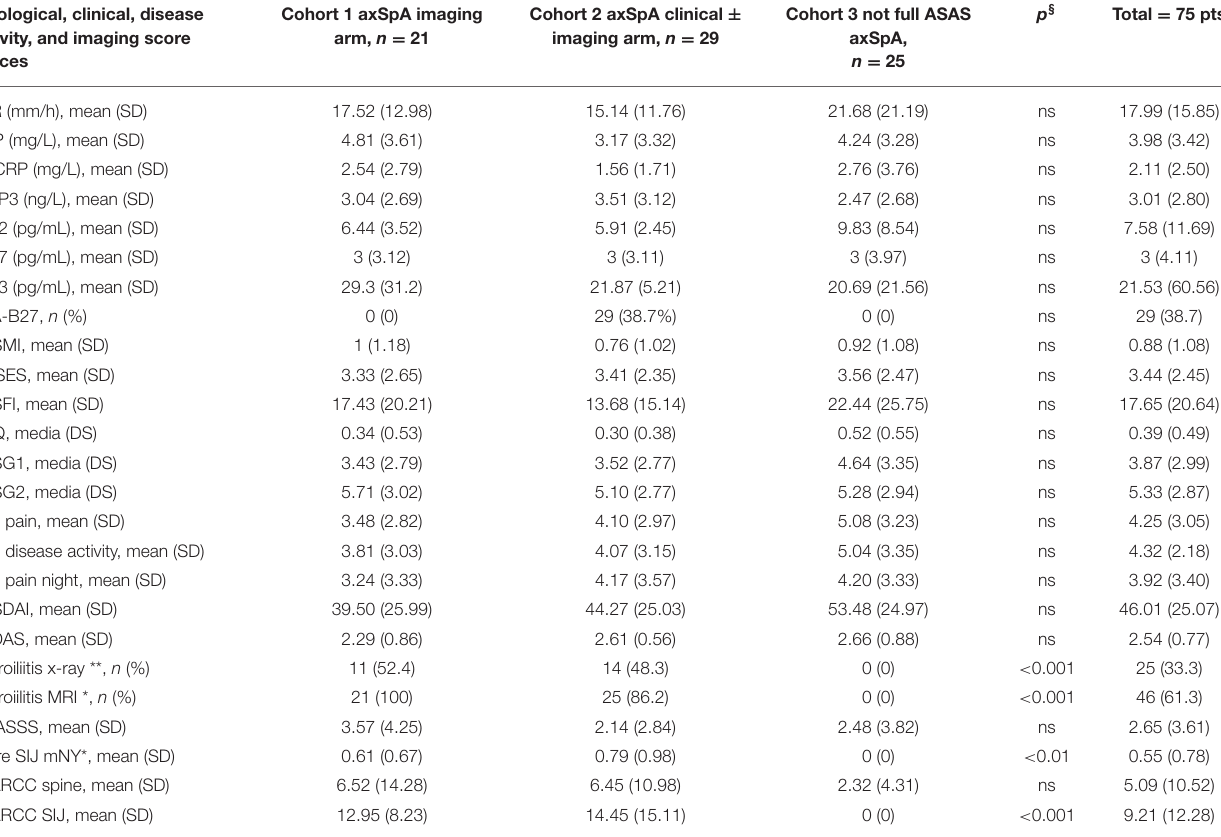
TABLE 4 | Serological, clinical, disease activity indices and imaging score at T0 in the whole group of patients ( n = 75) and in the three cohorts (axSpA imaging arm, axSpA clinical ± imaging arm, not full ASAS axSpA). Serological, clinical, disease Cohort 1 axSpA imaging activity, and imaging score arm, n = indices